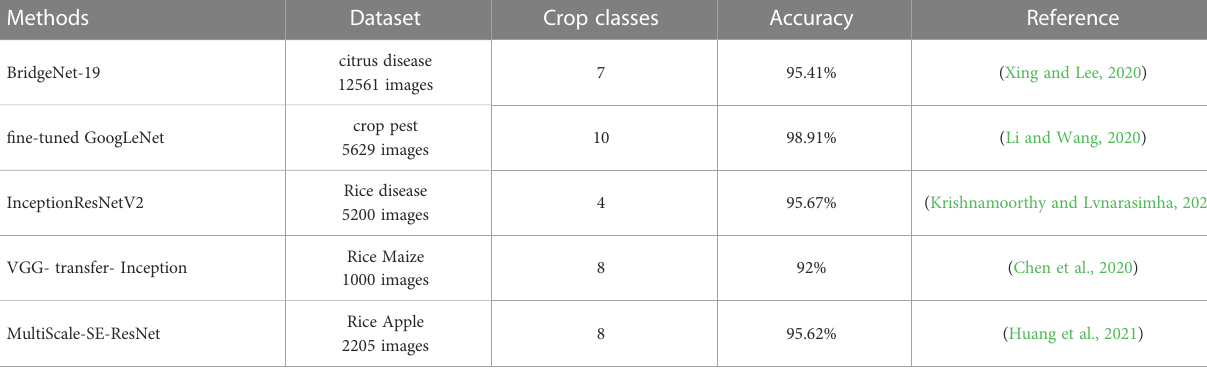
TABLE 6 Summary comparison of crop pest and disease identi fi cation